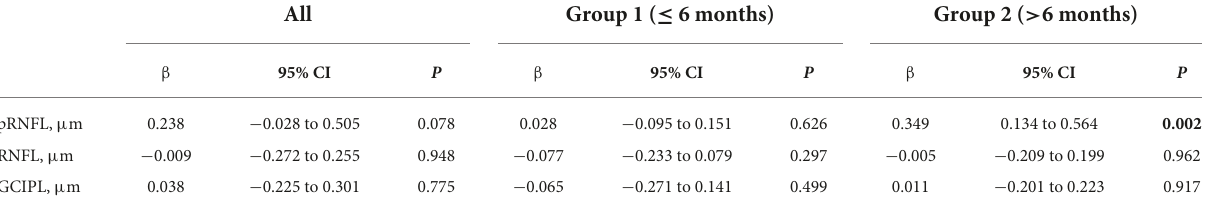
TABLE 2 Associations between LI and retina structural parameters in patients with thalamic stroke.